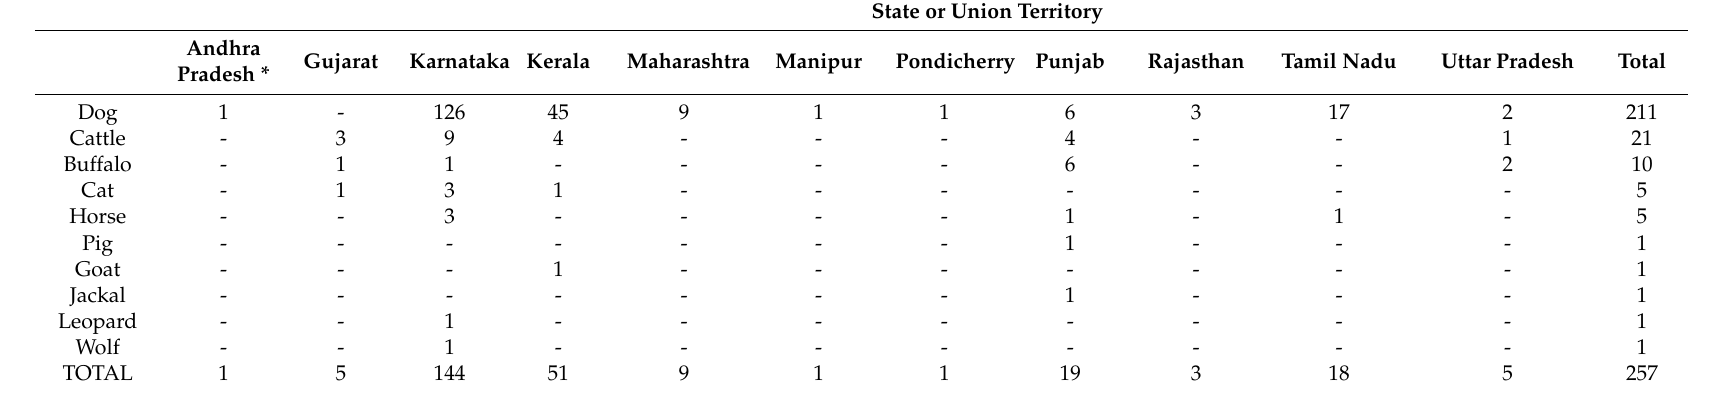
Table 1. Details of samples